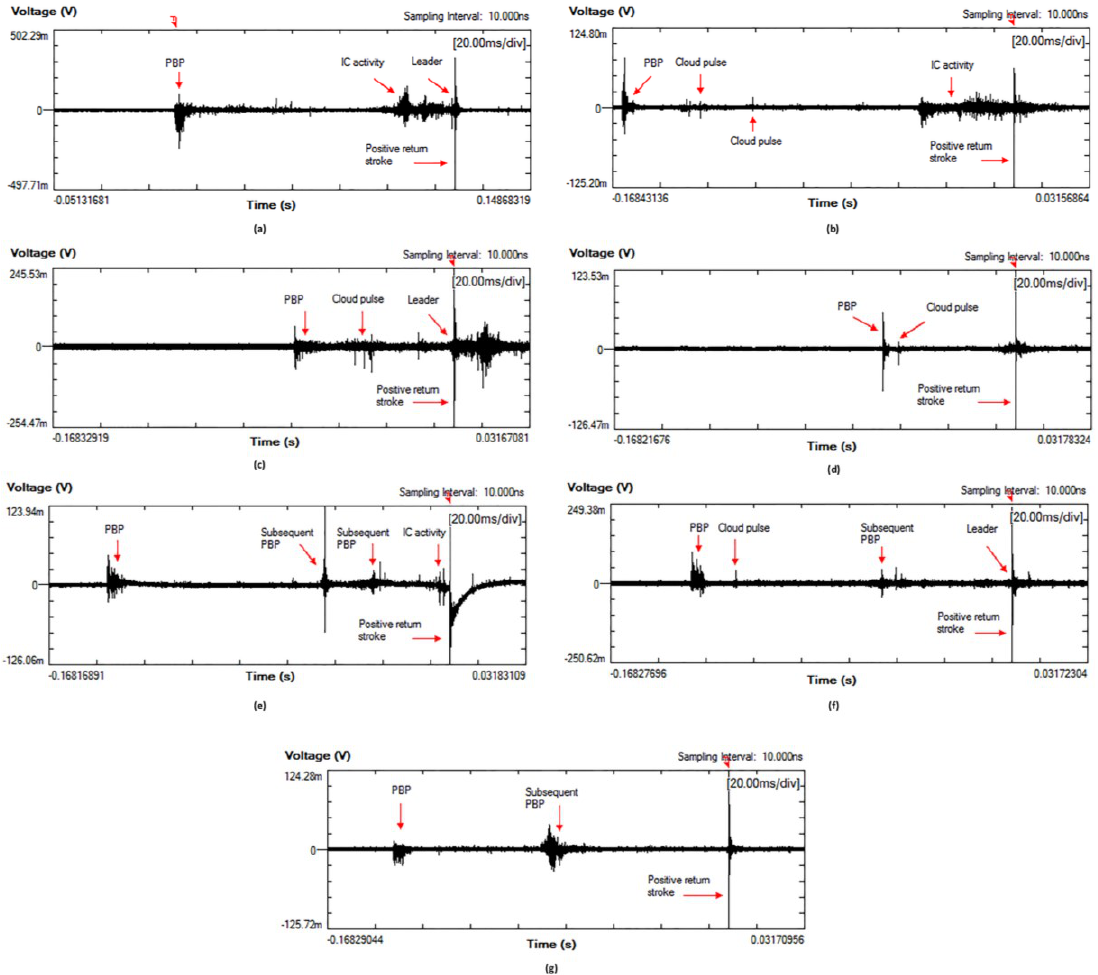
Figure 2. Sample waveforms showing PBP classifications ( a ) Single train PBP followed by in-cloud